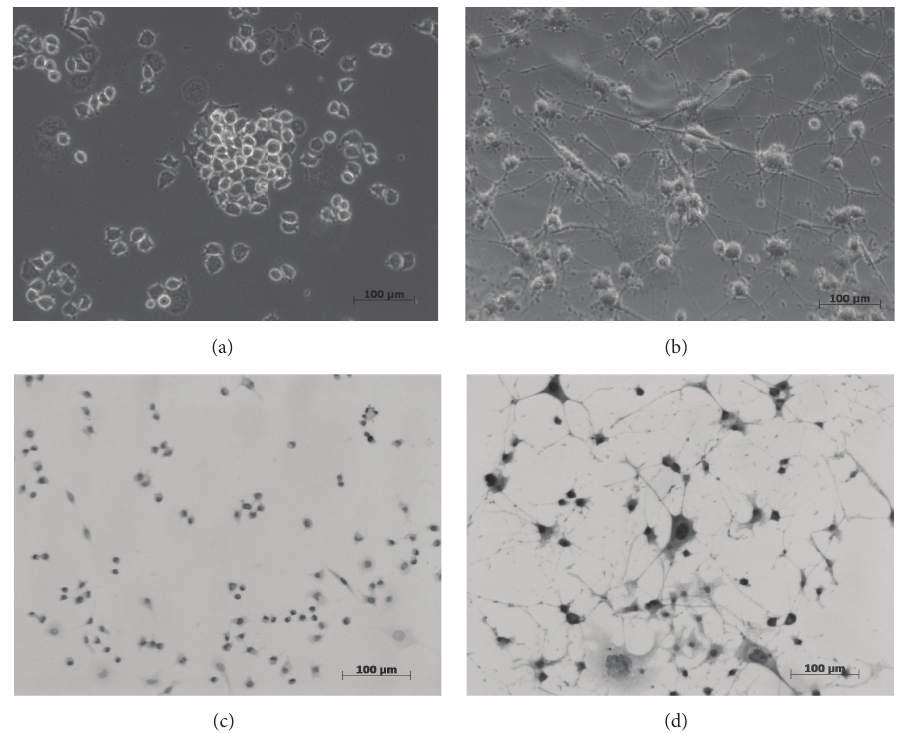
Figure 2: The characterization of the PC12 cell model. (a)/(b) The morphologies of PC12 cells before/after exposure to NGF. (c)/(d) The staining results of microtubule-associated protein 2 (MAP2) before/after exposure to NGF. (Scale bar = 100 𝜇 m.)